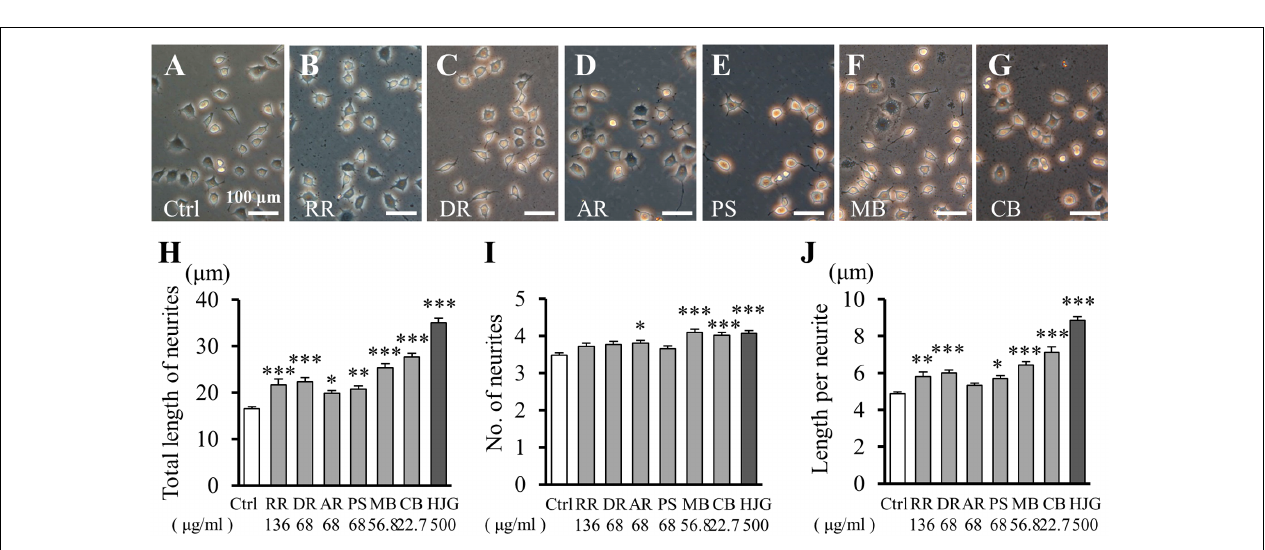
FIGURE 2 | Effects of HJG constituents on neurite outgrowth of PC12 cells. PC12 cells were incubated for 72 h with each of the following constituent herbs: (A) Ctrl, (B) RR, 136 µ g/ml, (C) DR, 68 µ g/ml, (D) AR, 68 µ g/ml, (E) PS, 68 µ g/ml, (F) MB, 56.8 µ g/ml, (G) CB, 22.7 µ g/ml, and HJG, 500 µ g/ml. Scale bar = 100 µ m. Total length of neurites (H) , numbers of neurites (I) , and length of individual neurites (J) were observed. Data represent mean ± SEM from three independent experiments. ∗ p < 0.05, ∗∗ p < 0.01, and ∗∗∗ p < 0.001 represent significant differences compared with controls (ANOVA followed by Dunnett’s